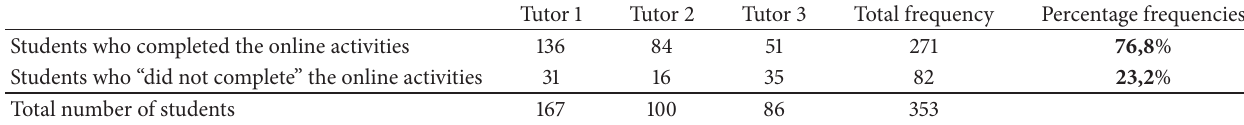
Table 1: Distribution of groups and tutors with the frequency distribution of students who completed the online laboratory tests or